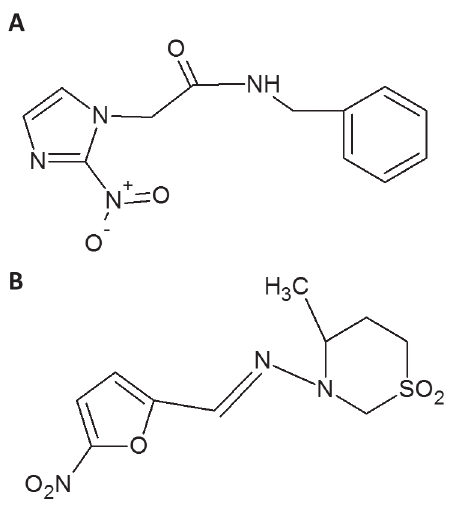
Figure 2 - Chemical structures of benznidazole (A) and nifurtimox